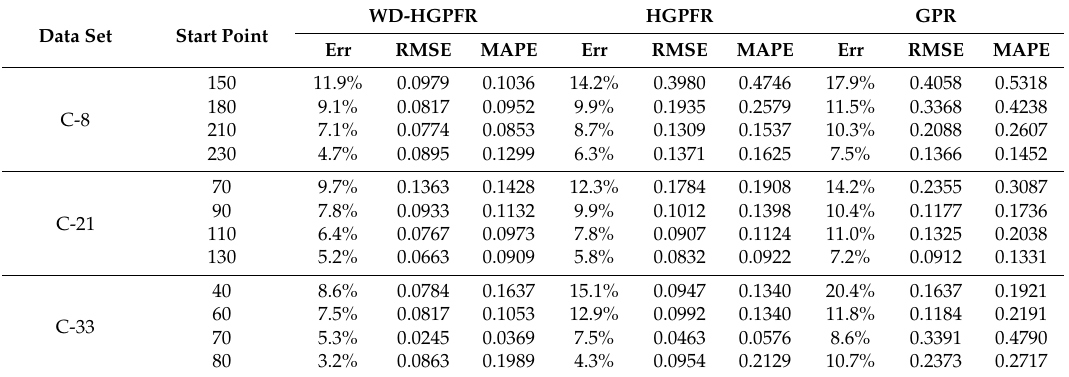
Table 2. Prognostic results and evaluation criteria using different methods with different lengths of training